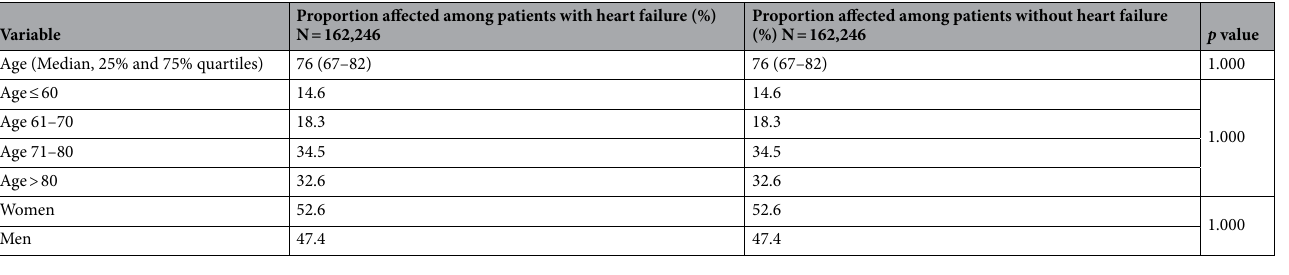
Table 1. Age and sex structure of the study sample (after 1:1 matching by sex, age, and index year). Proportions of patients given in %, unless otherwise indicated. SD: standard